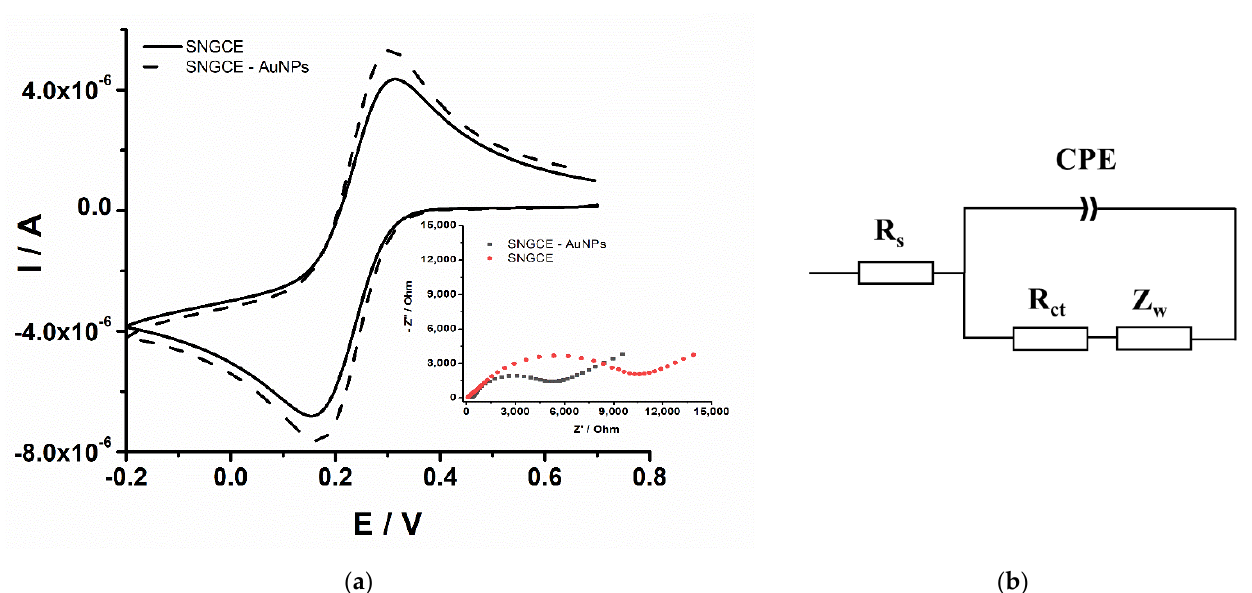
Figure 2. ( a ) CVs recorded at SNGCE and SNGCE/AuNPs in the presence of 5 mM K 3 Fe(CN) 6 in 0.5 M KNO 3 aqueous solution. Potential scan rate: 0.5 V s − 1 . Inset: EIS recorded at SNGCE and SNGCE/AuNPs in the presence of 5 mM K 3 Fe(CN) 6 /K 4 Fe(CN) 6 in 0.5 M KNO 3 aqueous solution. ( b ) Equivalent electrical circuit used in the fitting of the EIS